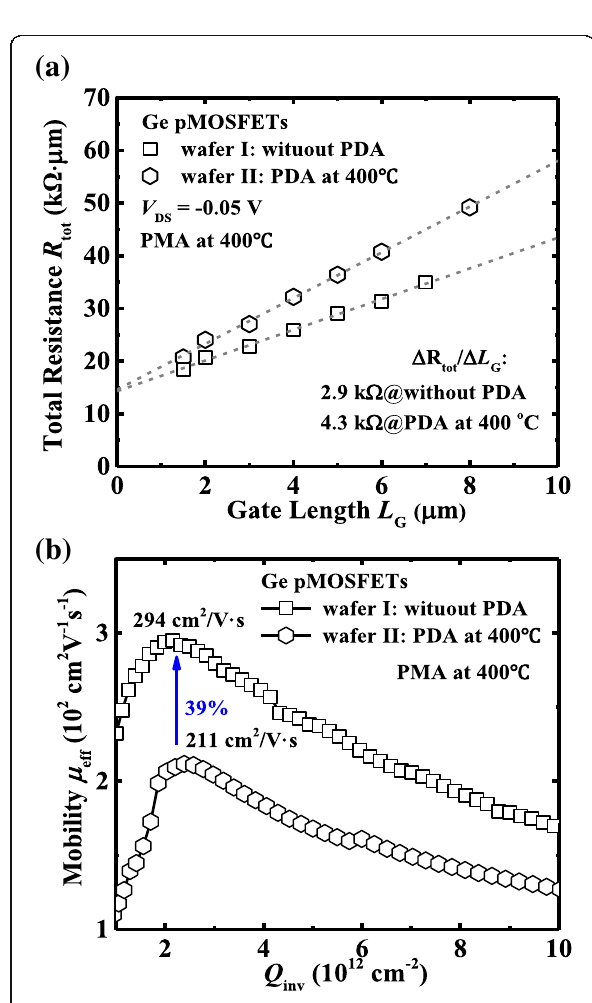
Fig. 9 a R tot vs. L G curves for devices on wafer I and wafer II with PMA at 400°C. b Hole mobility μ eff vs. Q inv for devices with and without PDA